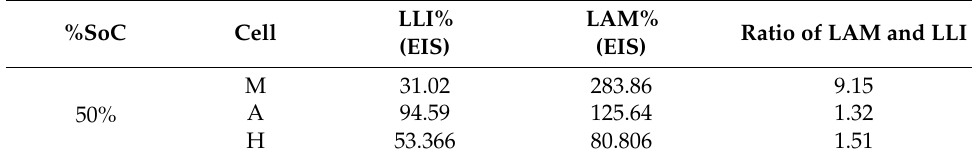
Table 8. EIS data of the cells for different DM groups.